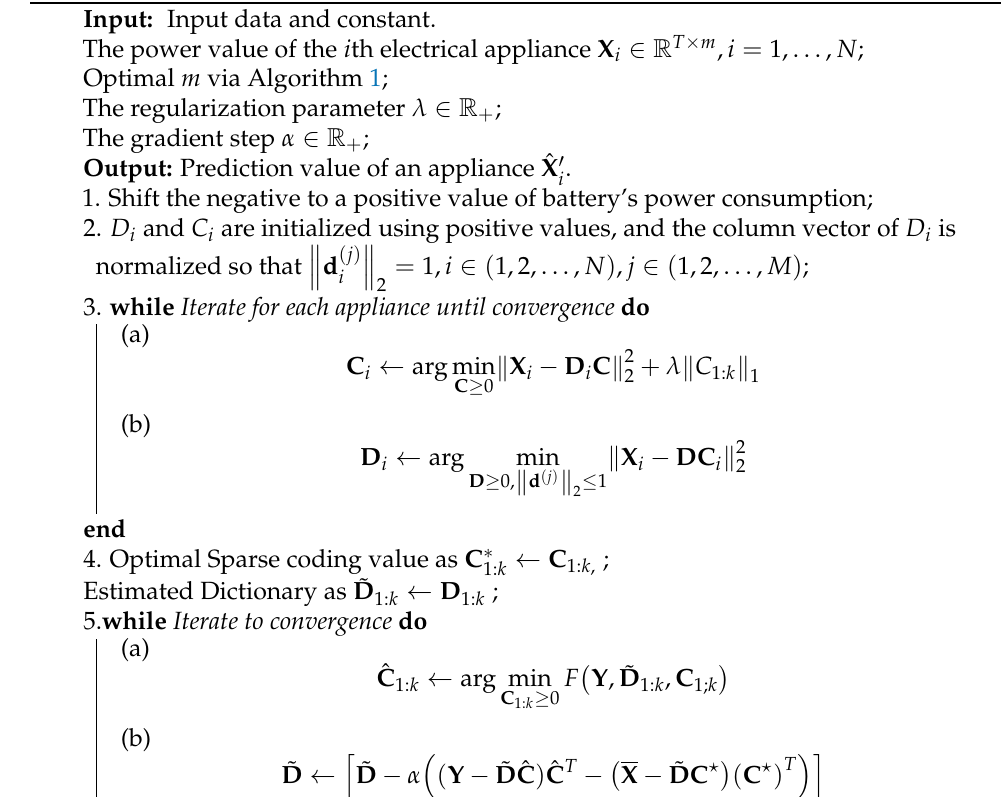
Algorithm 2: Improved dictionary learning sparse coding